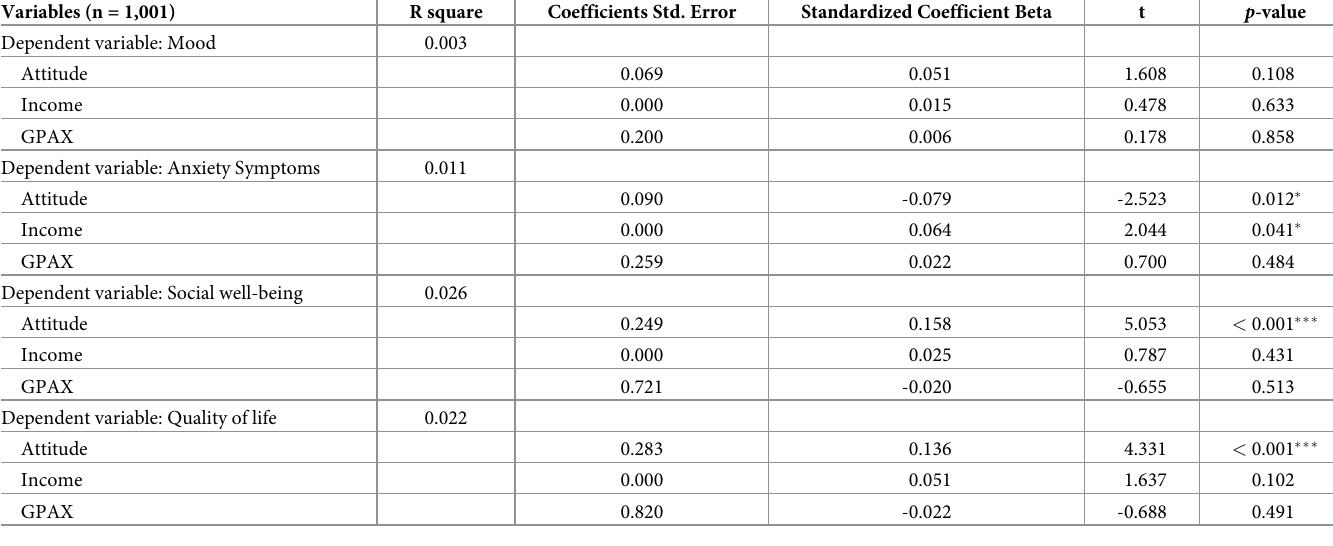
Table 5. Attitude towards the COVID-19 pandemic and its influence on anxiety, social well-being, and quality of life among Thai health professional students dur- ing the early “new normal” informing policy. Variables (n =